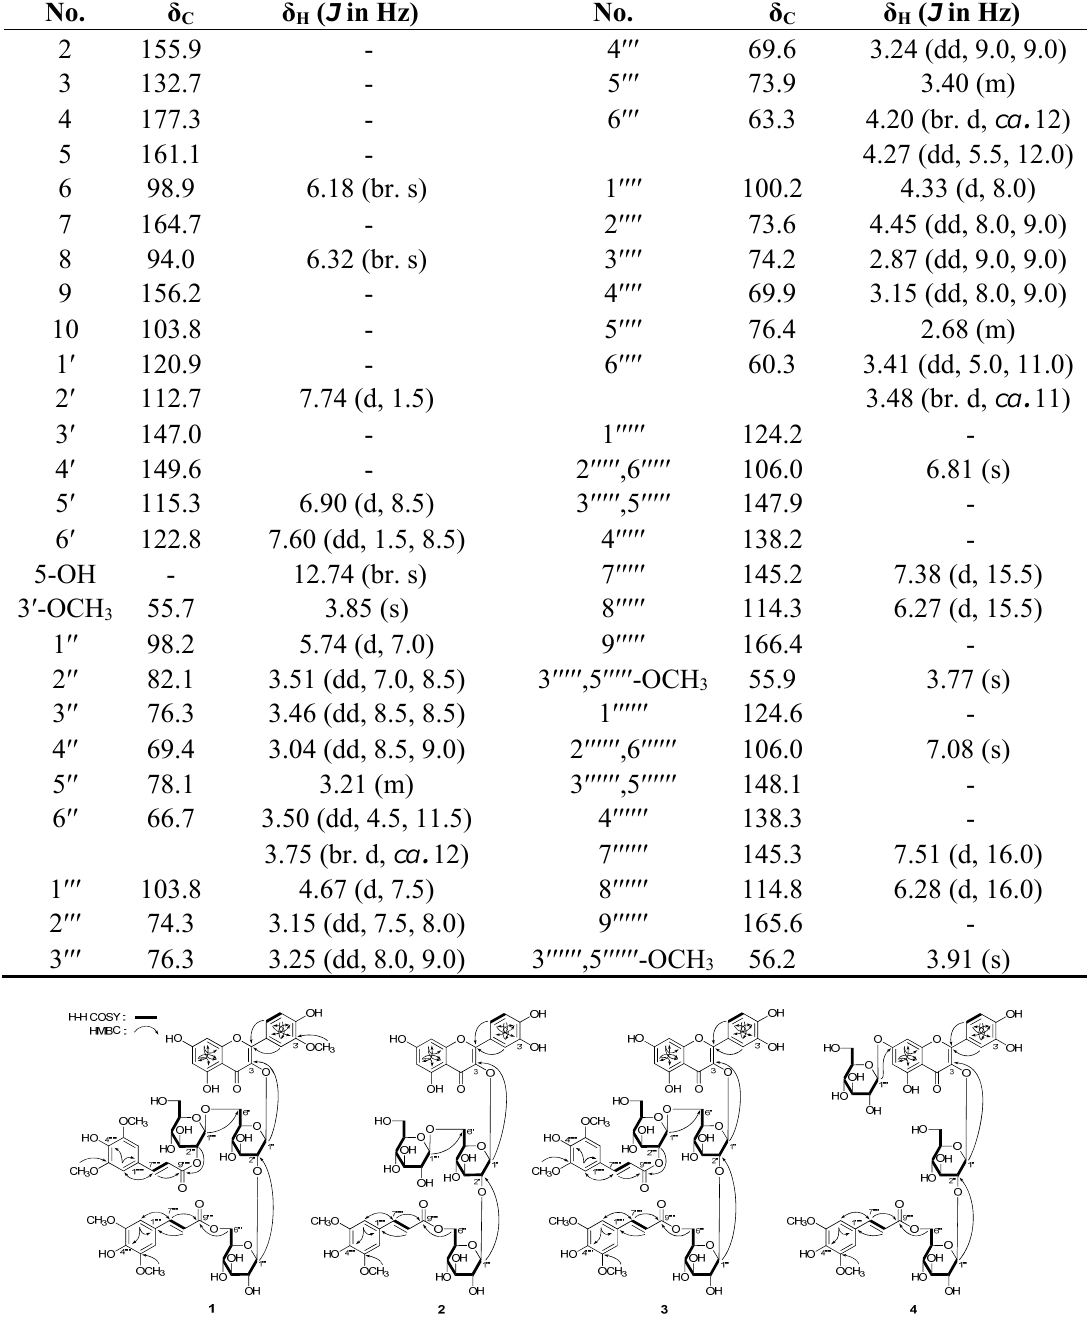
Figure 2. The main 1 H 1 H COSY and HMBC correlations of 1 – 4